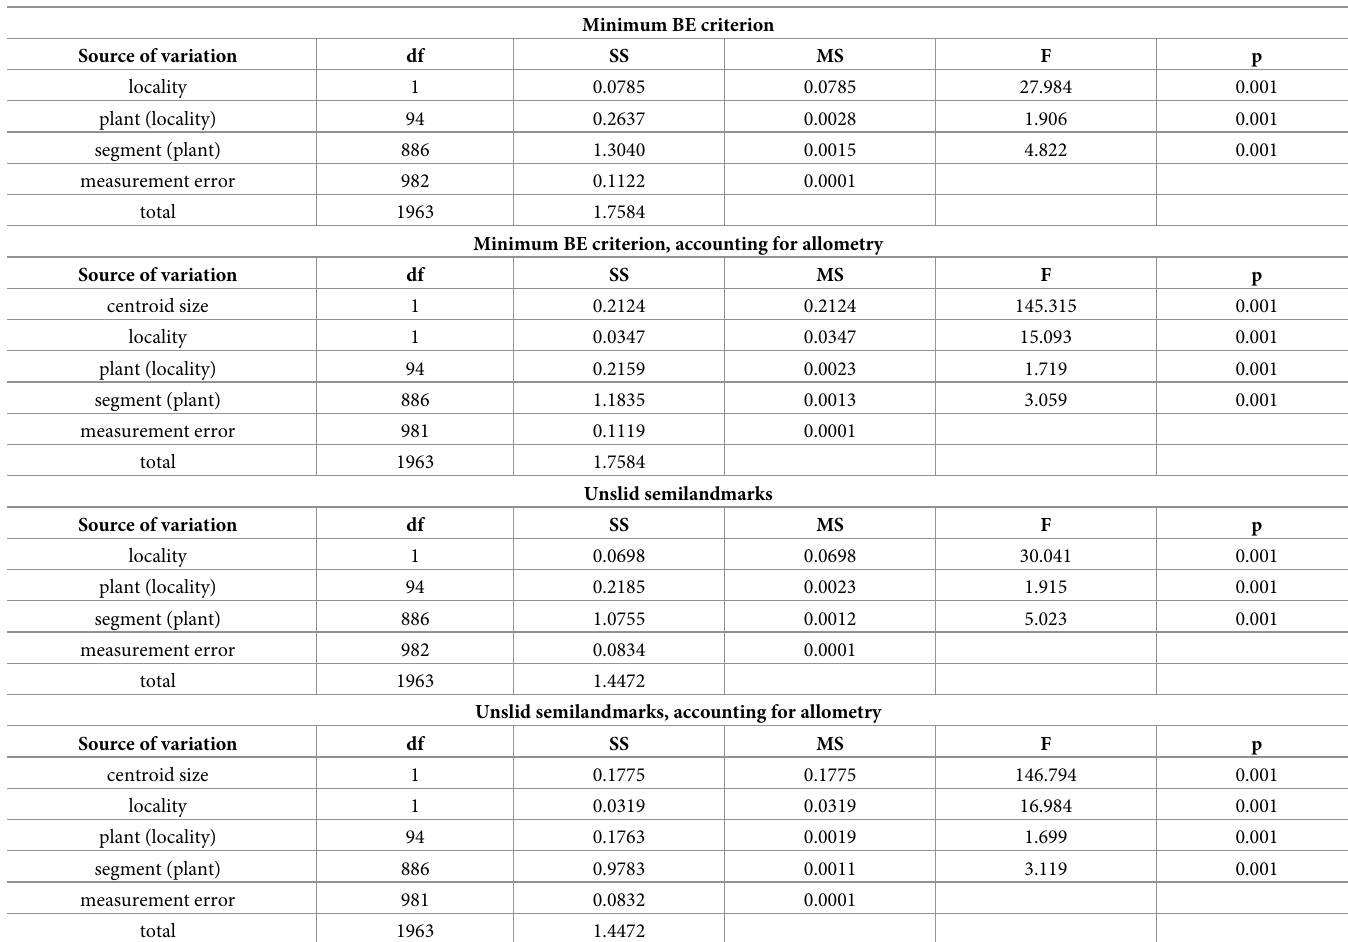
Table 1. Nested ANOVA models for total shape asymmetry of H . tuna